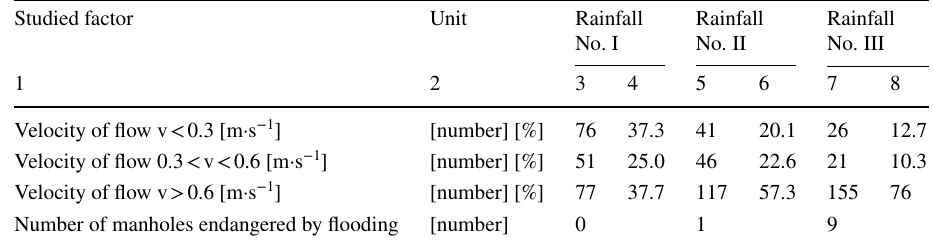
Table 5 Results of numerical calculations for different rainfall events—catchment with an increased proportion of the sealed surface